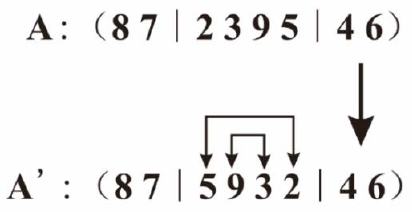
Figure 6. Example of mutation operation.